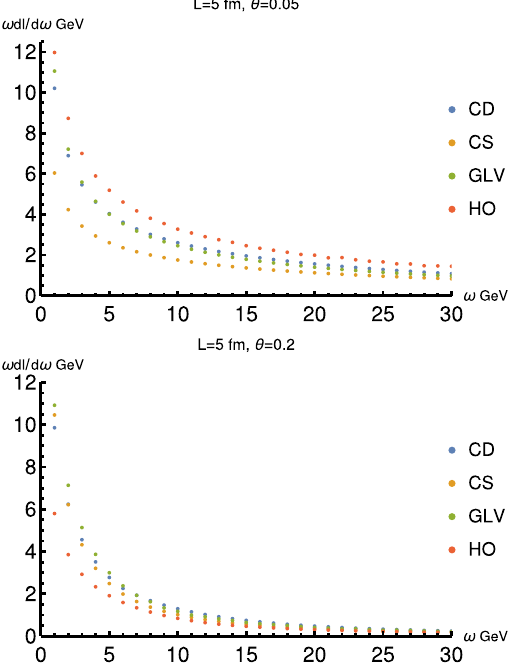
Fig. 2 The energy loss in the leading order in α s for L = 5 fm for dif- ferent values of θ as a function of the radiated gluon energy ω , divided by α s C F for different parameterisations of Q ( ˆ q ,ω,θ) for HO and total (HO + Coulomb) contributions: CD, CS are the total (HO + Coulomb)